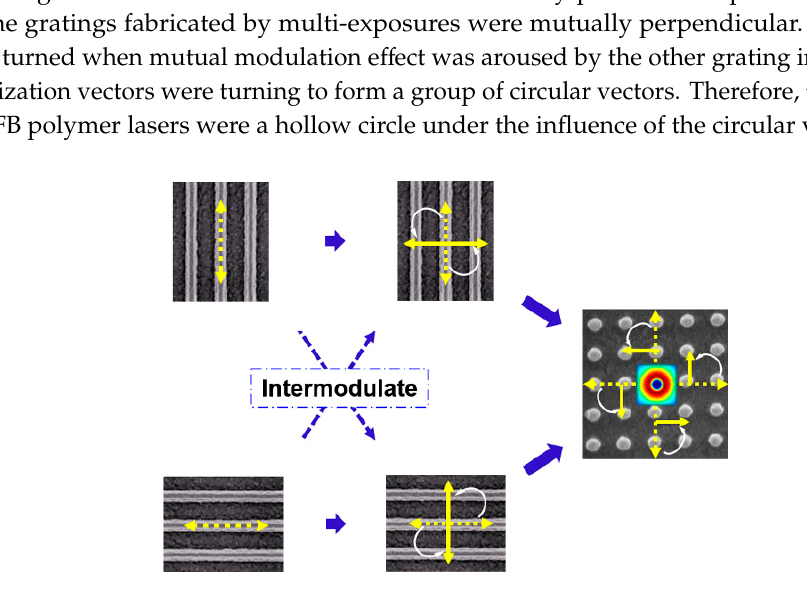
Figure 1. SEM images of ( a ) a 1D distributed feedback (DFB) grating and ( b – e ) 2D DFB gratings. The period is 335 nm. ( f – j ) Simulations of the interference pattern. ( k ) The transverse magnetic and transverse electric waveguide modes of different DFB gratings.